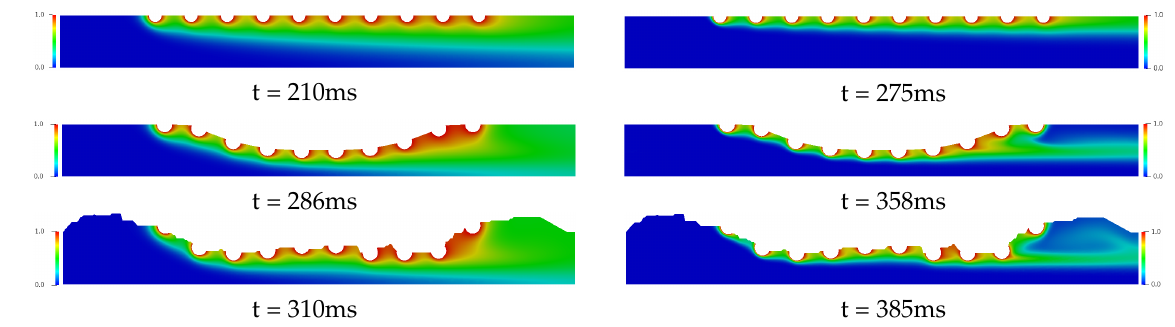
Figure 8. The spatial and temporal distribution of the concentration diffusion using the Sc = 1 ( left column ) and Sc = 10 ( right column ) drug coefficients for the Straight Channel, the Curved channel and the Real Channel with the drug-eluting stent. It is estimated that the concentration field for Sc = 1 is significantly more diffuse than in the Sc = 10, where the Schmidt number is 10 times higher. This means that a large portion of the diffused drug in bloodstream is quickly spread in the Sc = 1 case.